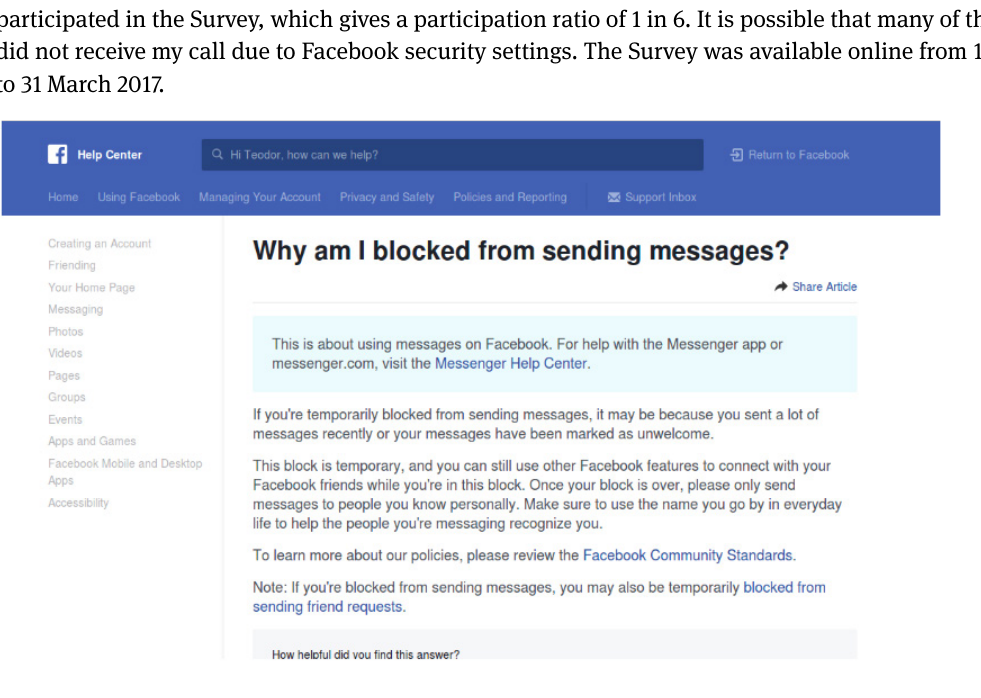
Figure 2. Facebook blocked three times the account used during this project from sending